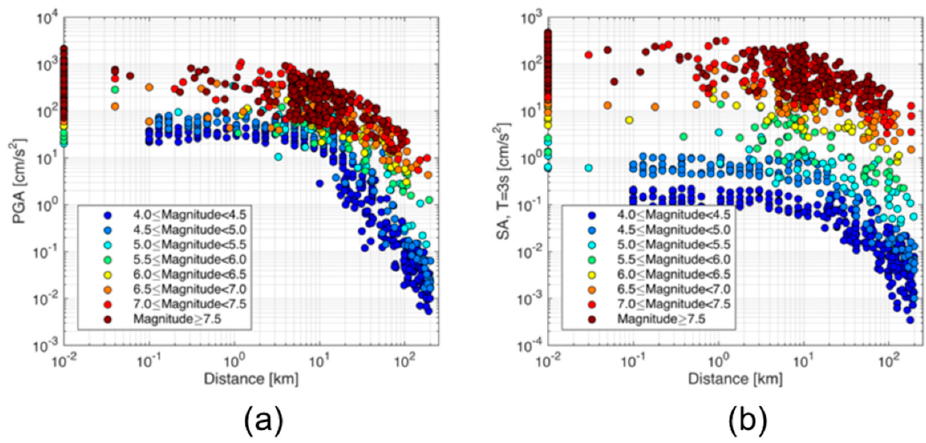
Figure 19. Distribution of ground-motion parameters of SET1 as a function of distance for different classes of magnitudes: PGA ( a ) and spectral acceleration (SA) ( b ) ordinates at T = 3 s. Table 4. Median values and standard deviations of the coefficients of SI17hyb.